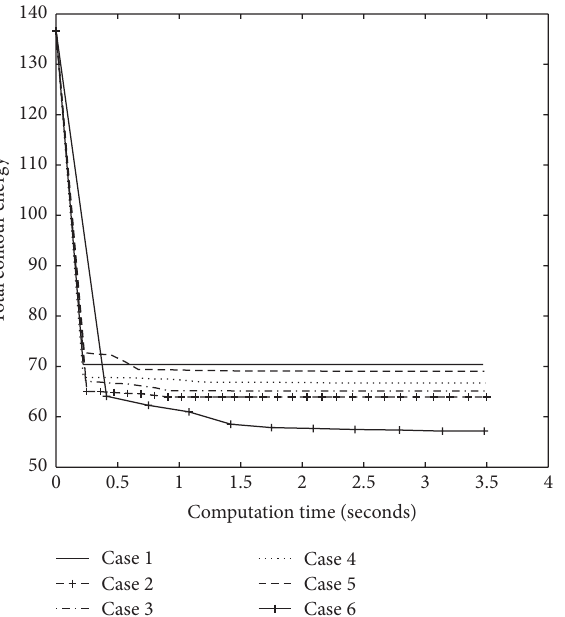
Figure 11: Contour energy versus computation time plot for “proposed multiswarm PSO” method with six different cases of inertia in case of “MRI”